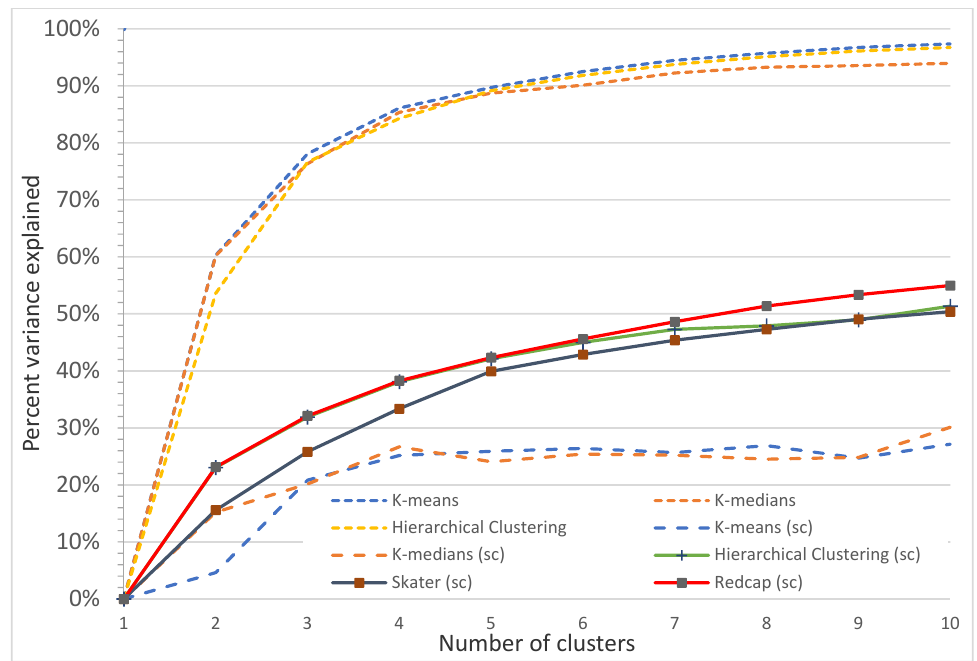
Figure A17. Plot of percentage of the variance explained as a function of the number of clusters generated by eight algorithms for the Koala Coast intra-subregional Group 7 polygon group. This elbow plot indicates that 2–4 classes is the optimum, e.g., for nonspatial algorithms, 3 classes explain 78.1% (K-means), 76.3% (K-medians), and 76.6% (Hierarchical clustering) of the variance, and 4 classes explain 86.1% (K-means), 85.4% (K-medians), and 84.3% (Hierarchical clustering) of the variance. For spatial algorithms (sc), Redcap explains a maximum of 32.1% (3 classes) and 38.3% (4 classes) of the